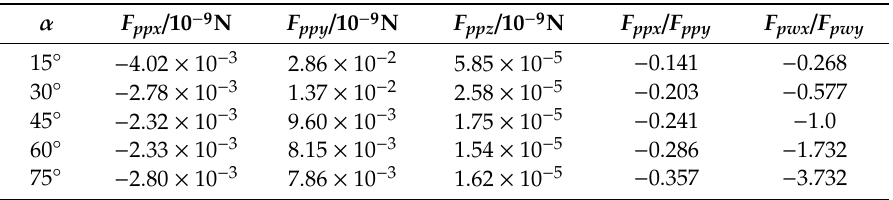
Table 2. Comparison of the directions of Van der Waals forces based on plate-plate and plate-wall model. α F / 10 − 9 N F / 10 − 9 N ppx ppy